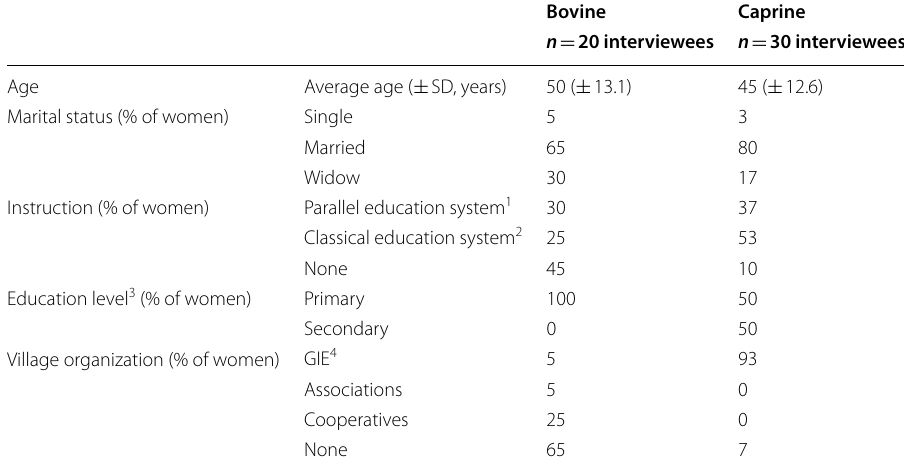
Table 2 Socio-demographic characteristics of women involved in bovine and caprine milk value chains in Fatick, expressed as percentage of interviewed